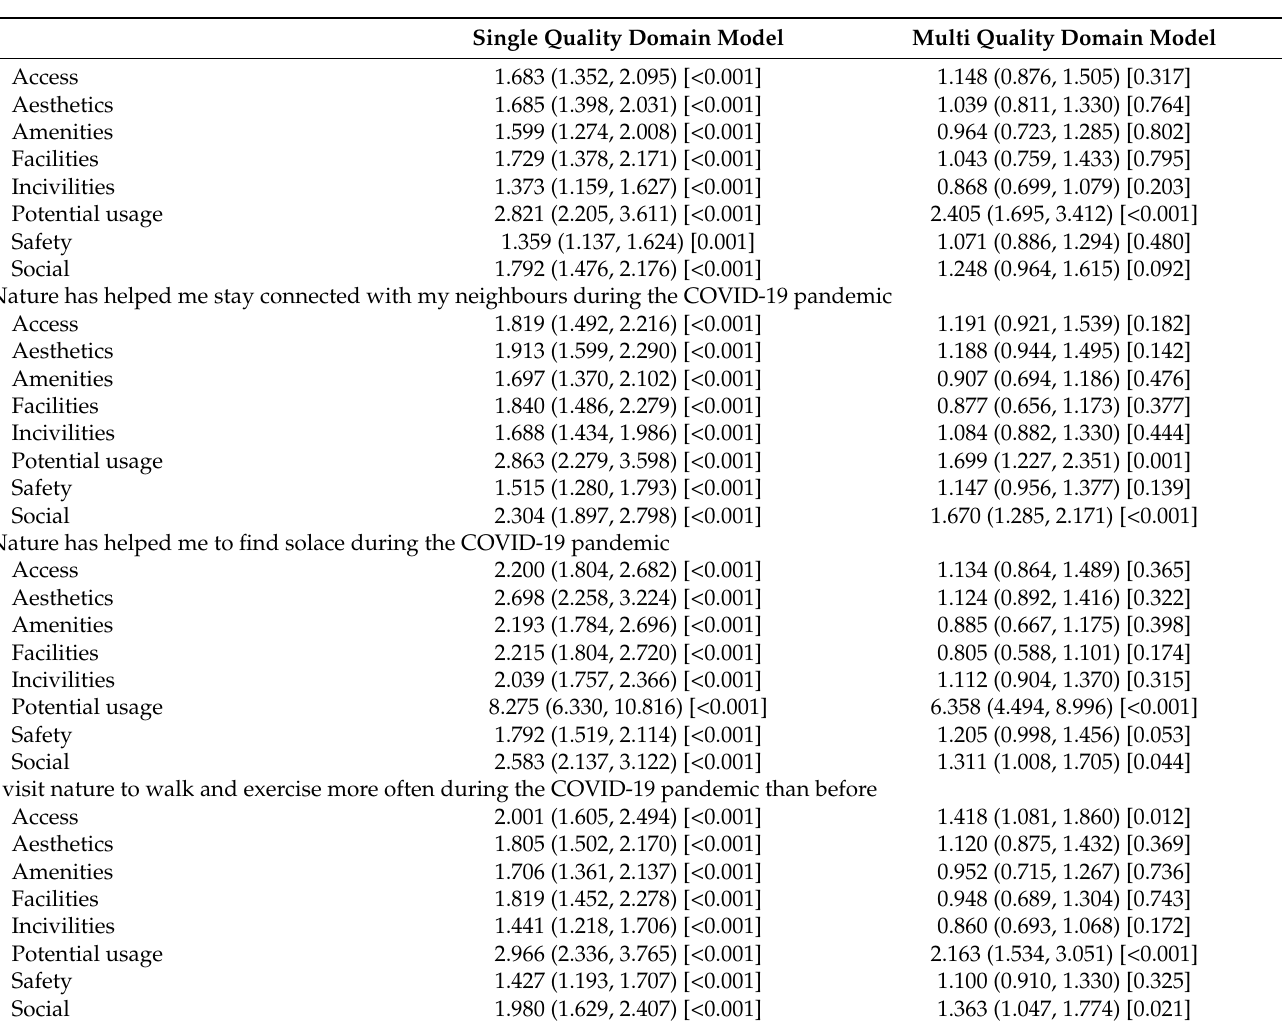
Table 5. Cont . Single Quality Domain Model Multi Quality Domain